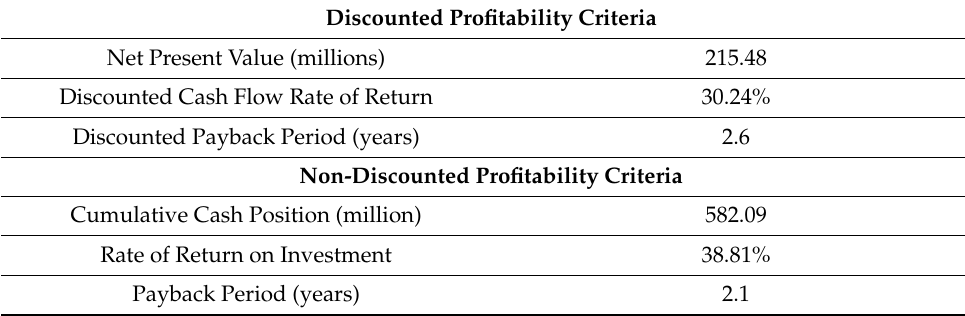
Figure 11. Cumulative cash flow diagram for FBMR and FBR. Table 11. Profitability criteria for